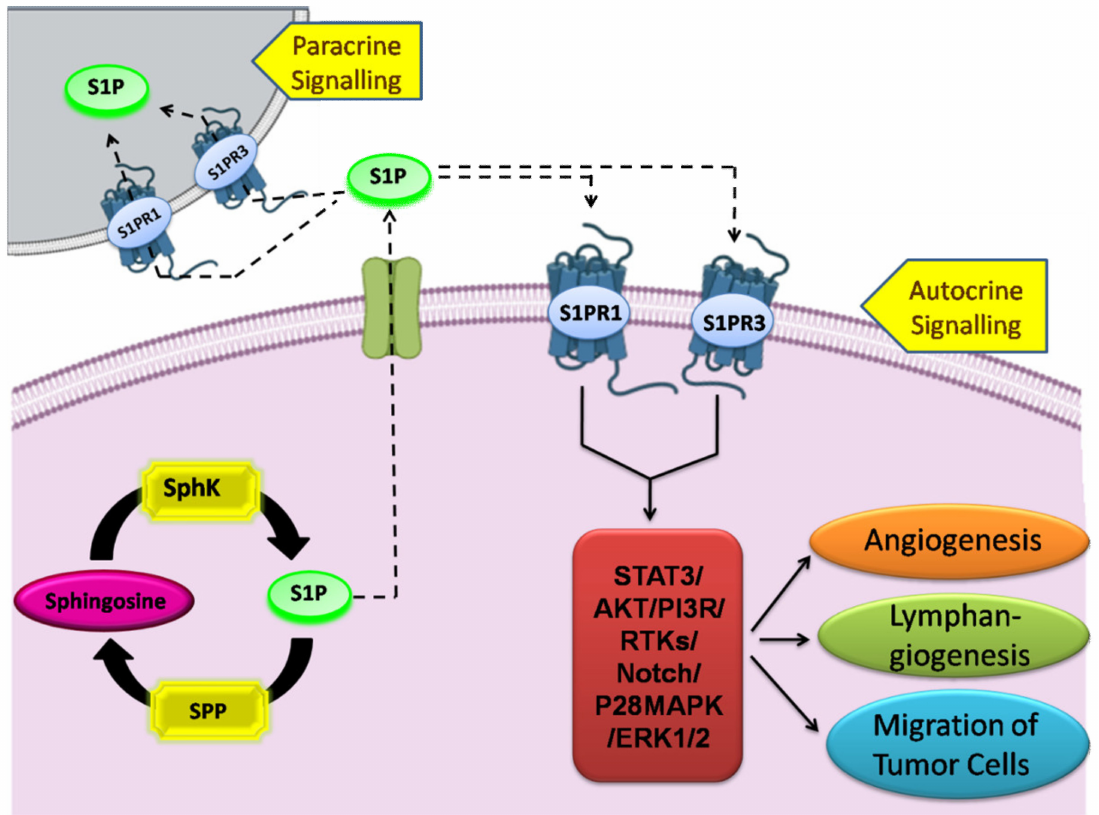
Figure 4. Schematic representation showing the role of the SphK1/S1P axis in breast cancer progression and metastasis. S1PR1 and S1PR3 are the two S1P receptors playing a major role in breast cancer development which initiate a cascade via activating STAT3, various RTKs, Notch, p38MAPK, ERK1/2, and AKT/PI3K cumulatively resulting in breast cancer